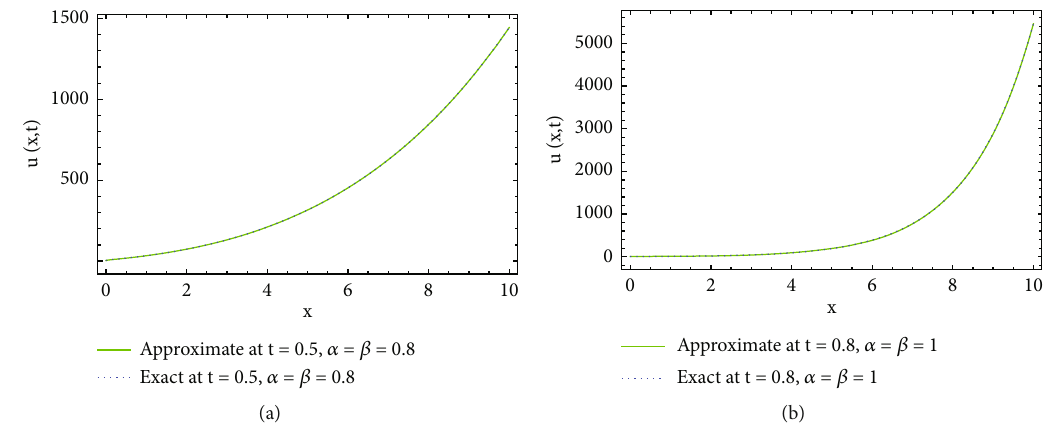
Figure 5: 2D solution plots of Example 1 obtained by the present method in comparison with the exact solutions for di ff erent values of fractional orders α and β .